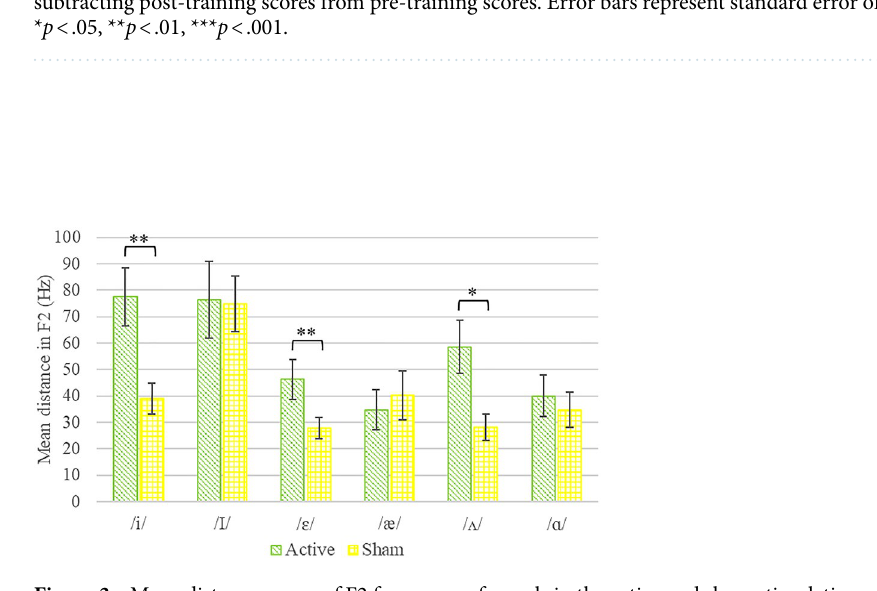
Figure 3. Mean distance scores of F2 frequency of vowels in the active and sham stimulation groups. Mean distance scores were calculated as the absolute value of the difference between post- and pre-training values. Error bars represent standard error of the mean. * p < .05, ** p ≤